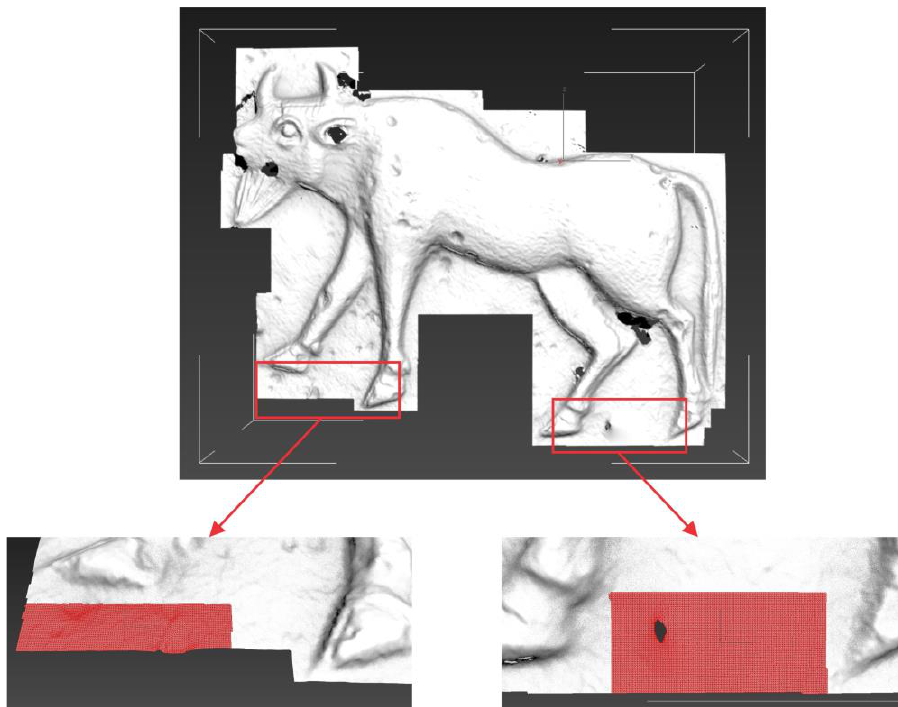
Figure 5. Isolation of the aurochs’ ornament with zoomed in details to highlight the high number of vertices acquired by the scanner to define the 3D ornament.